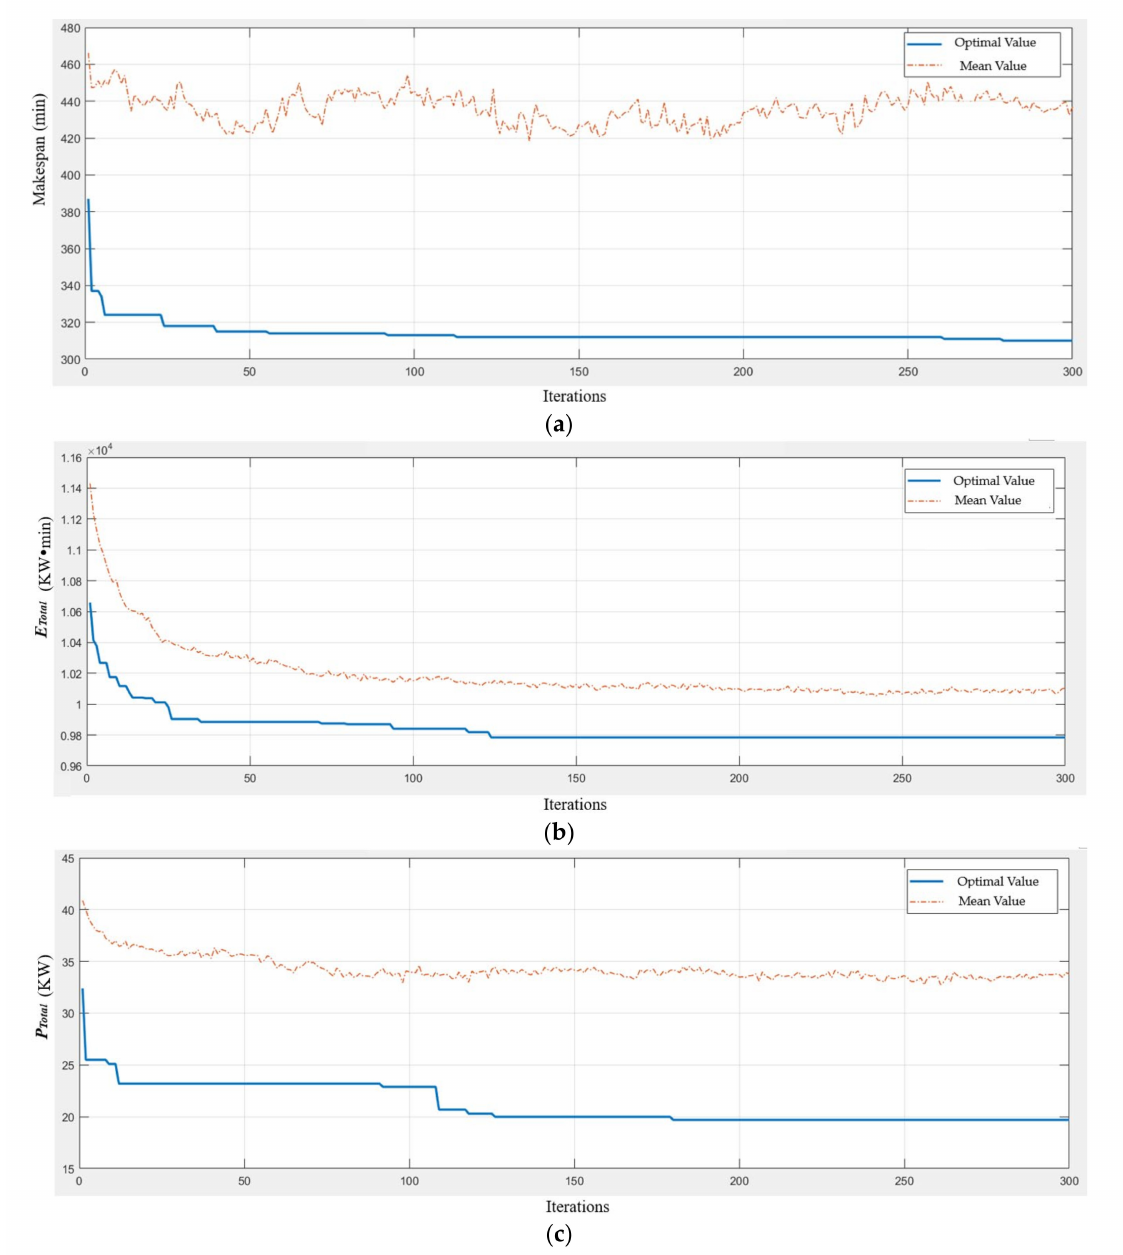
Figure 10. The change curves for the three optimization objectives in the iterative process: ( a ) optimal and mean values for the makespan ( C max ); ( b ) optimal and mean values for the total energy consumption ( E Total ); ( c ) optimal and mean values for the peak input power ( P Total